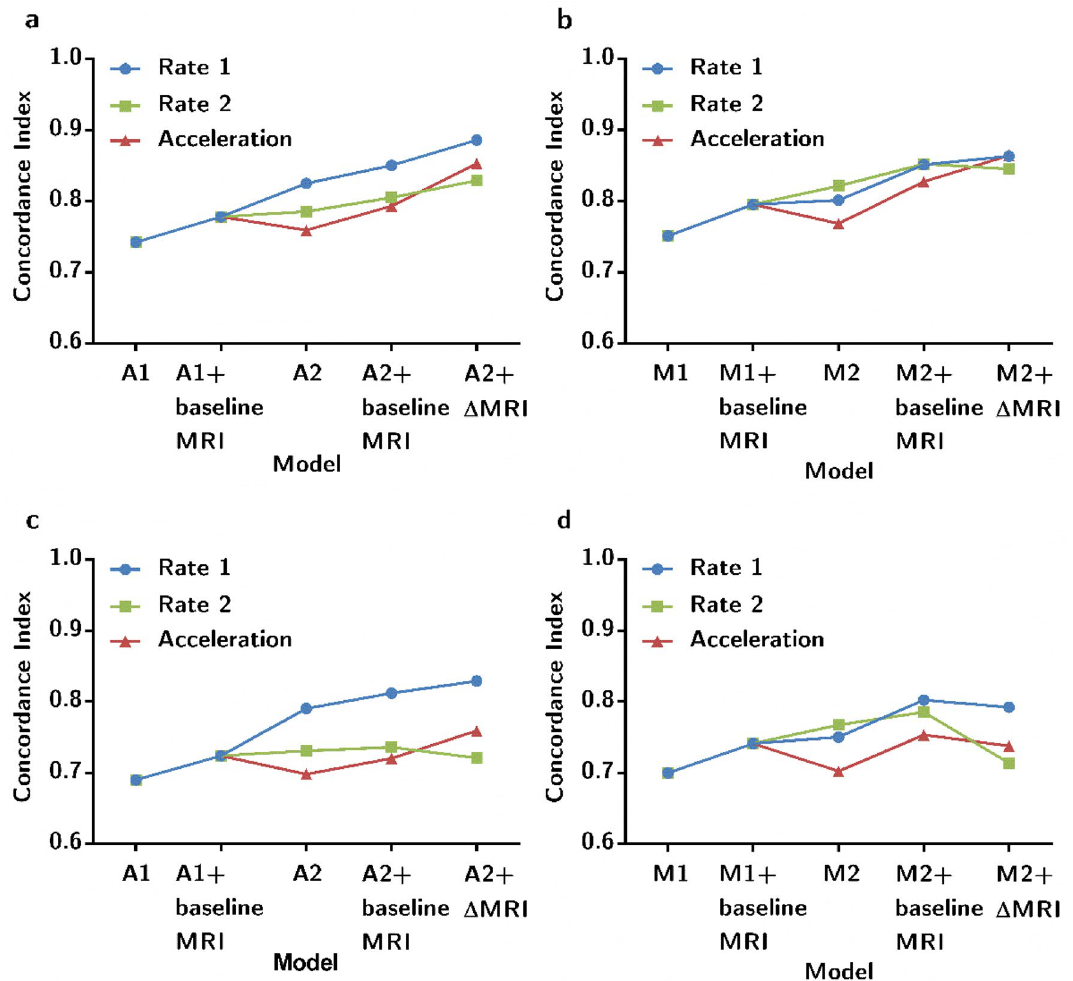
Figure 2. The concordance index (C-index) of models using different strategies to predict progression to dementia within 3 years. ( a ) The concordance index of ADAS-13 predictive dataset (N = 110); ( b ) the concordance index of MMSE predictive dataset (N = 92); ( c ) the concordance index of ADAS-13 predictive dataset by internet validation (bootstrap) (N = 110); ( d ) The concordance index of MMSE predictive dataset by internet validation (bootstrap) (N =